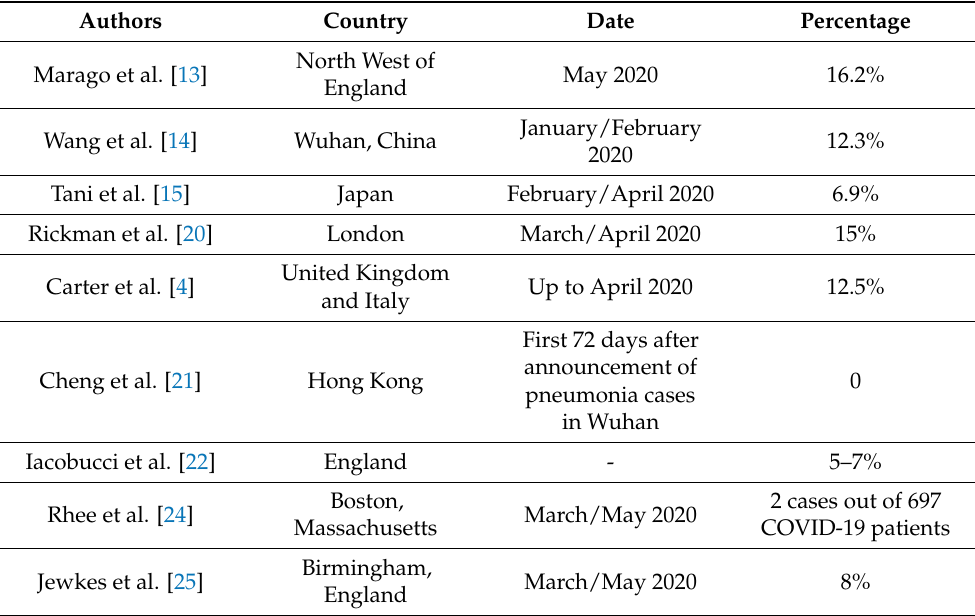
Table 1. Parameters of selected studies: country, observation period, and percentage of hospital- acquired SARS-CoV-2